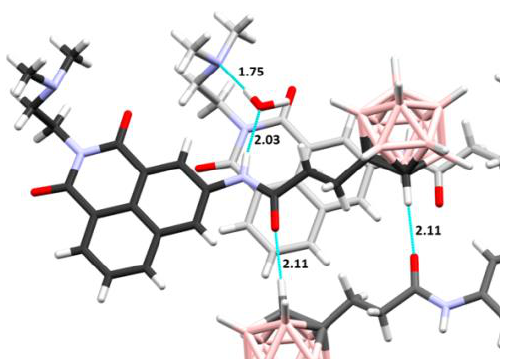
Figure 3. Intermolecular interactions seen in the crystal structure of 39 . Hydrogen bonds are indicated by dotted lines, and hydrogen donor–acceptor distances are shown in Å. The three molecules of carborane–naphthalimide conjugate are distinguished by distinct colors of carbon atoms in different shades of gray.